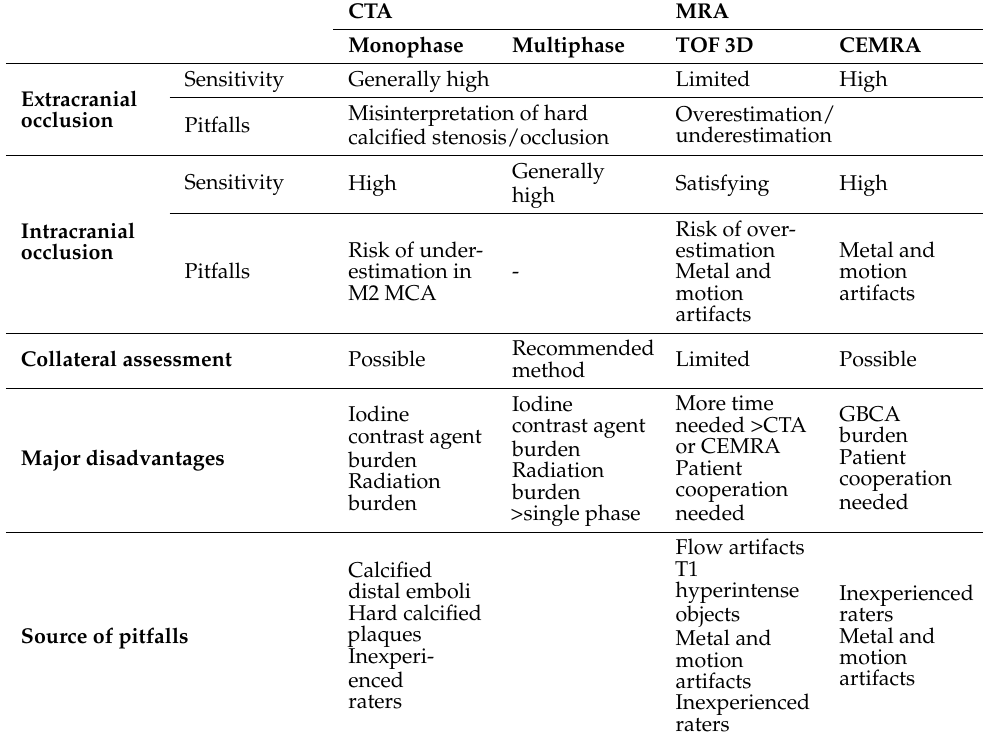
Table 1. CTA and MRA in the detection of extracranial and intracranial occlusion.